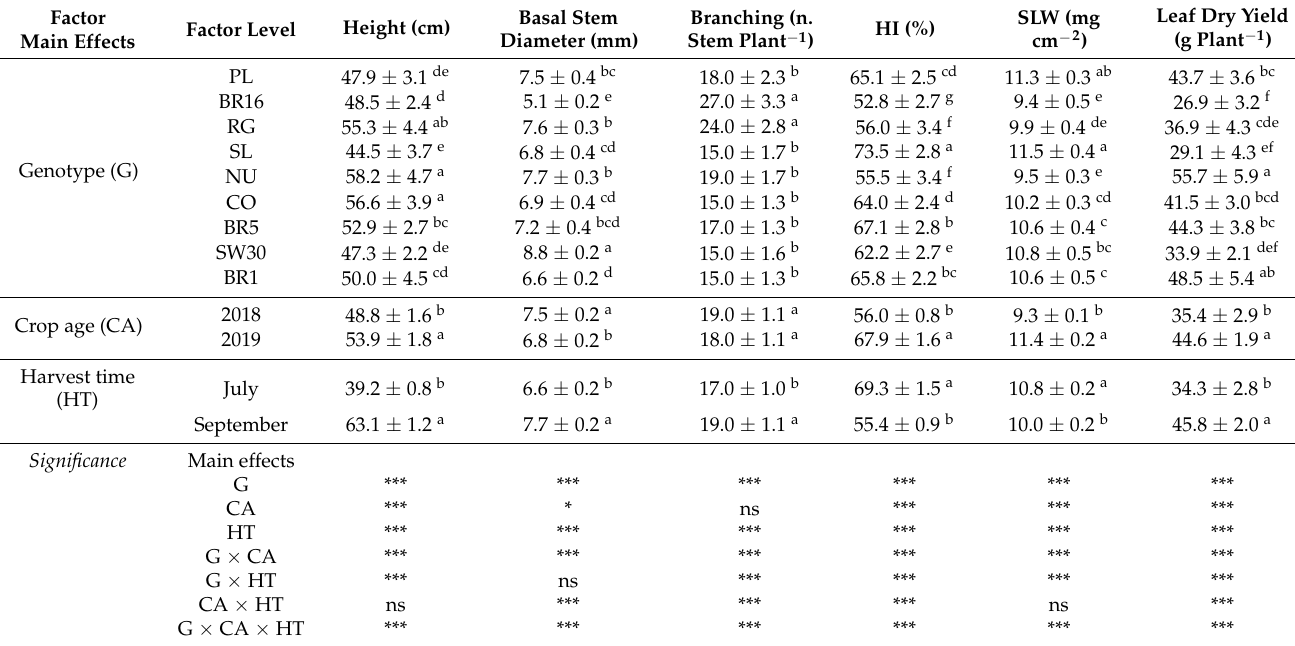
Table 4. Results of three-factorial analysis of variance (ANOVA) for agronomic characteristics of stevia genotypes tested in the open-field experimental